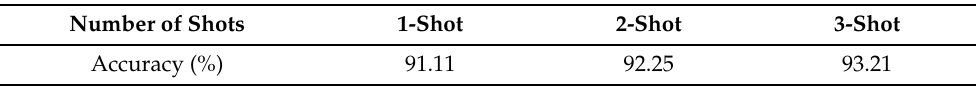
Table 7. The accuracy for different number of shots with four training